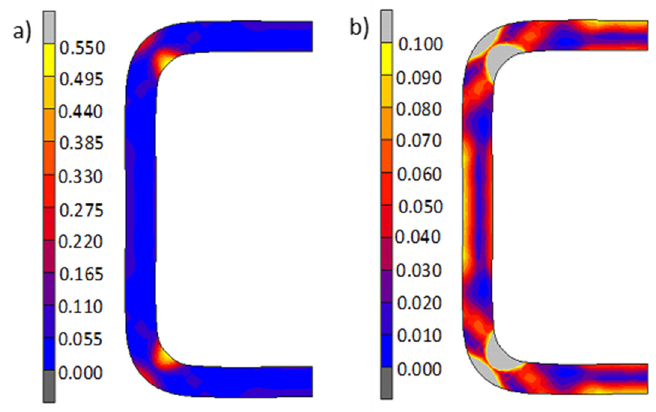
Figure 4. Distribution and values of the total equivalent plastic deformations in the pipe material after cold shaping; value scale: ( a ) strain range (0–0.55) and ( b ) strain range (0–0.10).